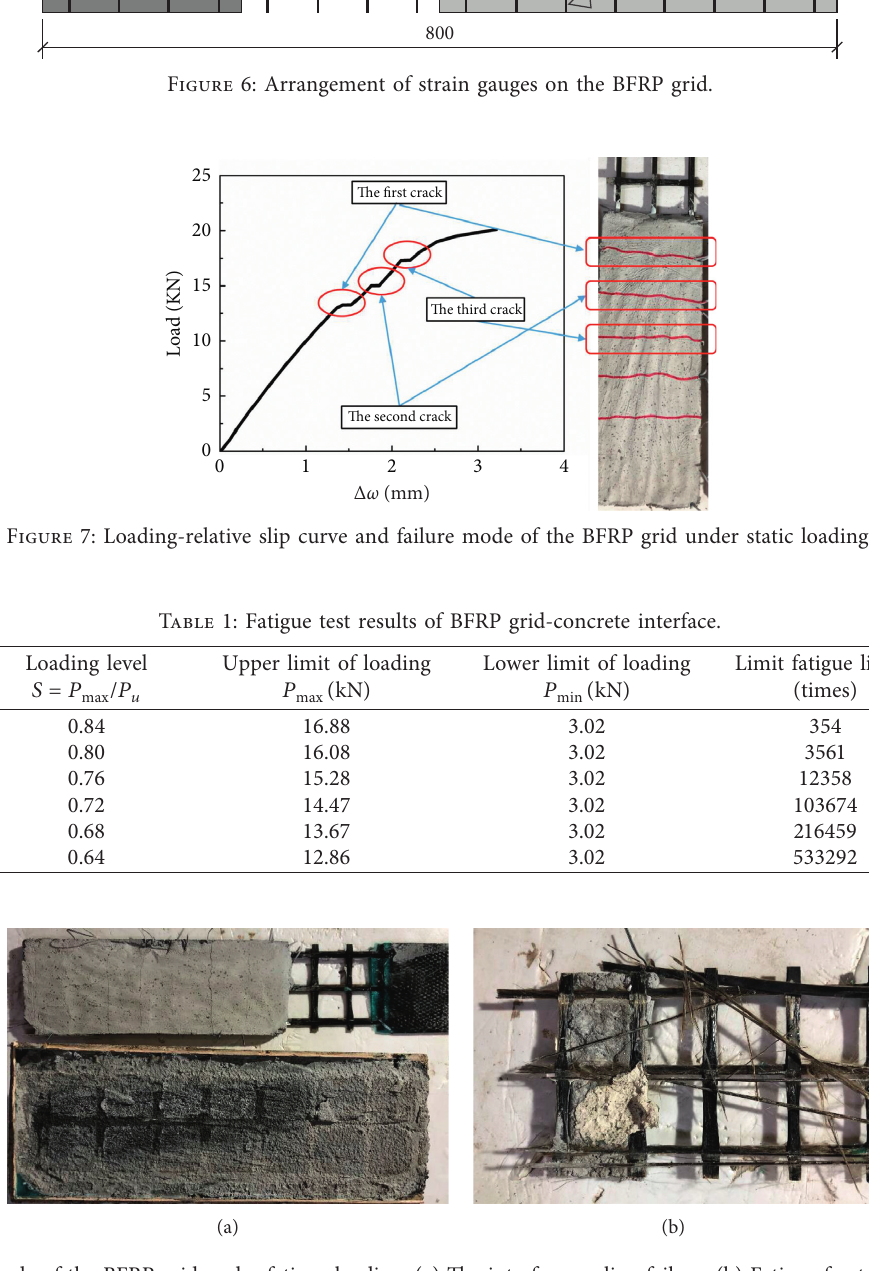
Figure 8: Failure mode of the BFRP grid under fatigue loading. (a) The interface peeling failure. (b) Fatigue fracture of the BFRP